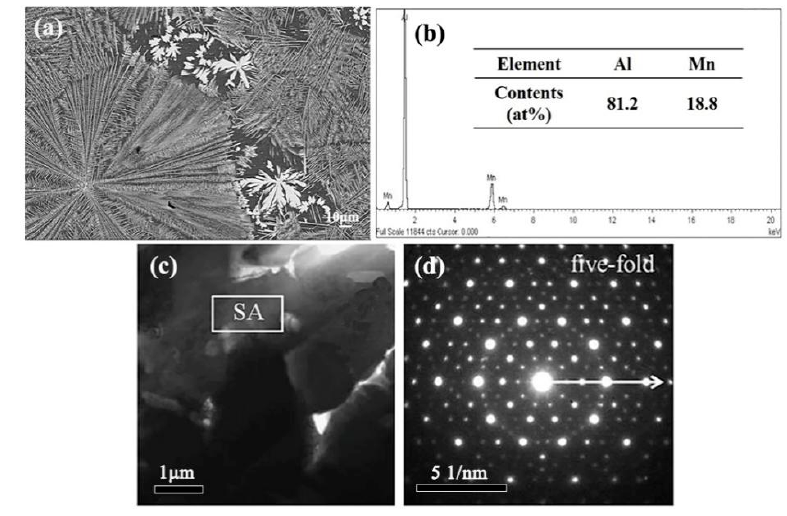
Figure 11. Microstructure of the cross-section of the cylindrical sample in suction casting Al–10 wt.%